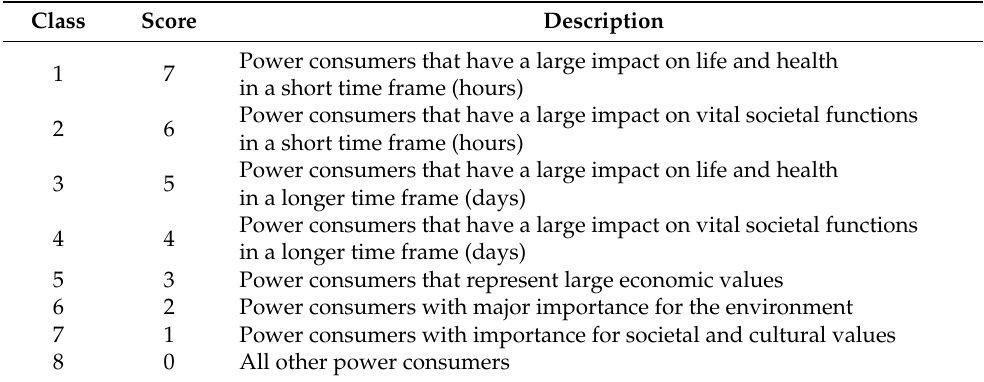
Table 2. Classification scheme of critical infrastructure